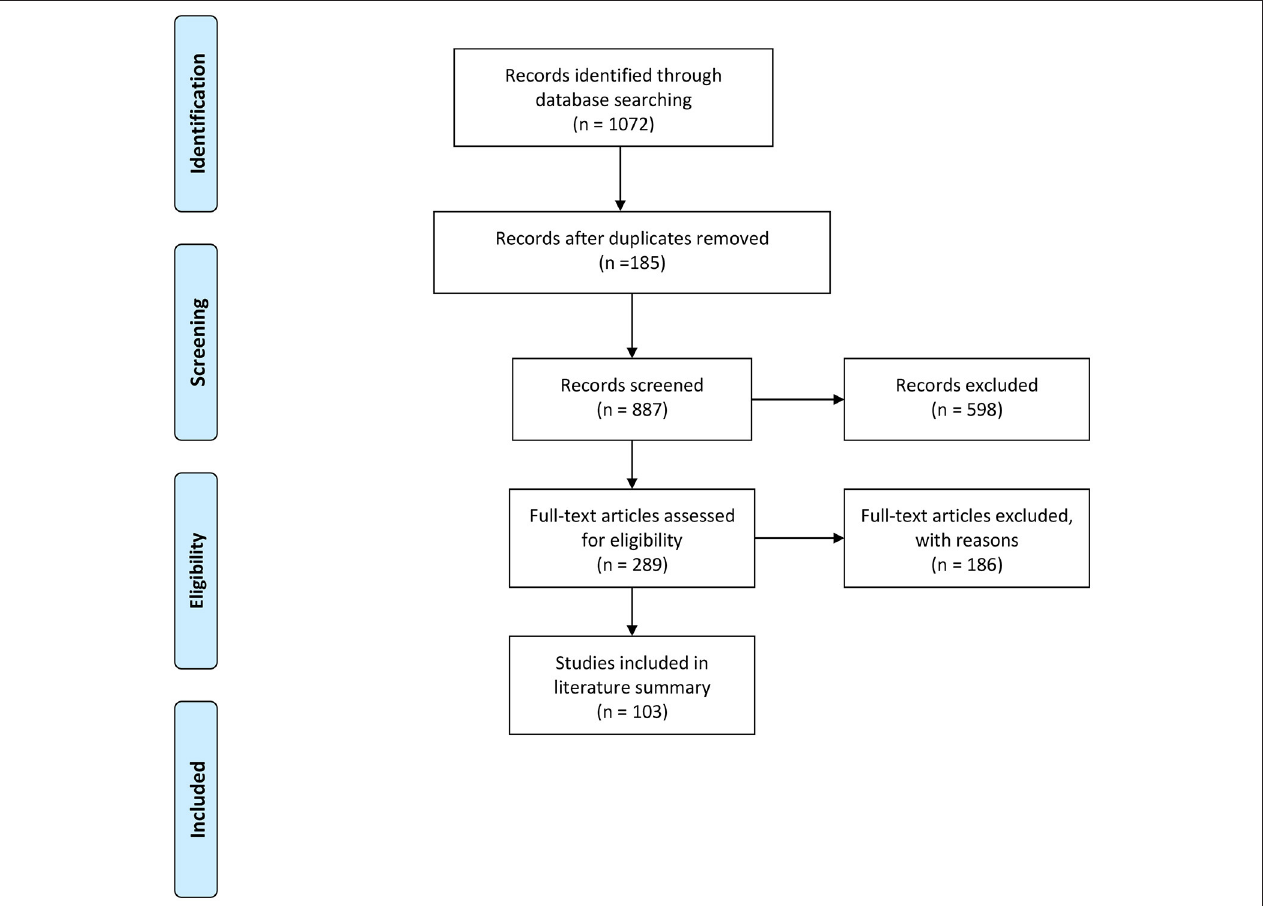
FIGURE 1 | PRISMA flow diagram of accessing artificial intelligence for clinical decision-making.